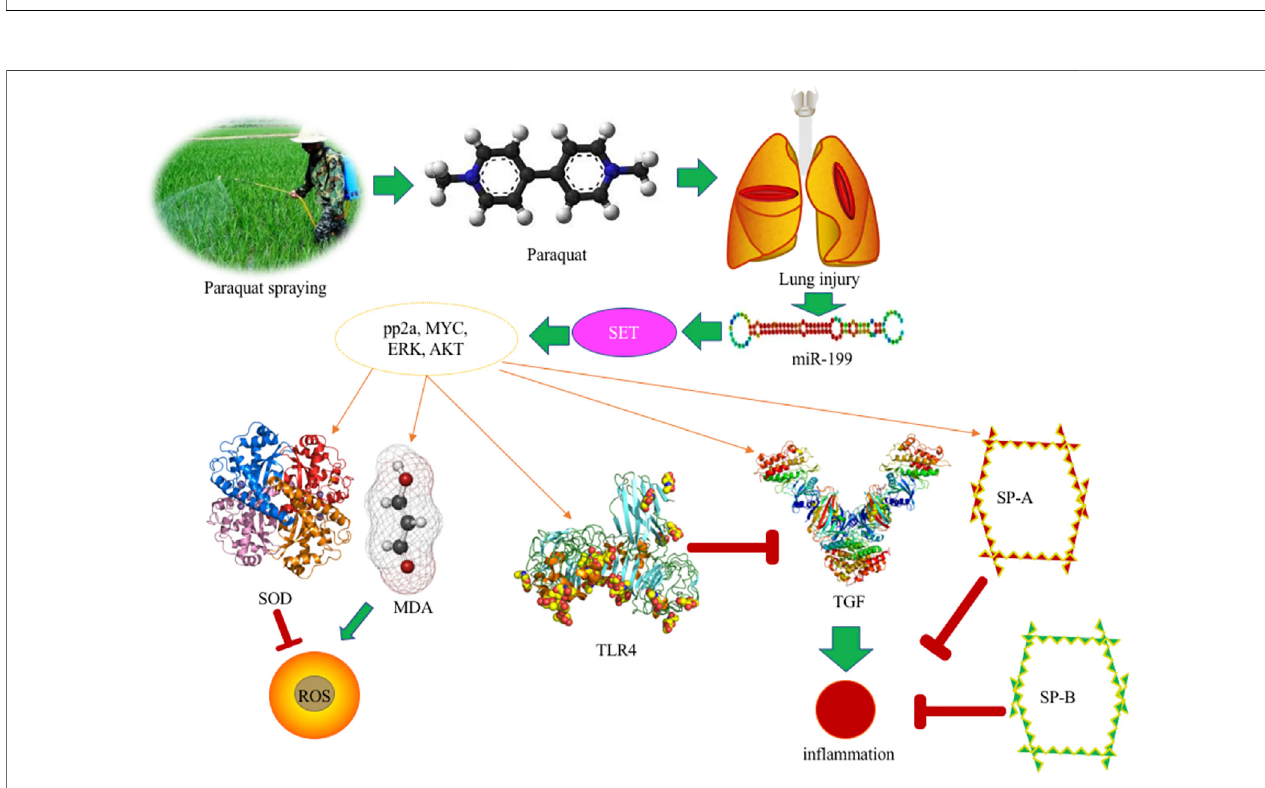
FIGURE 6 | Schematic plot of possible molecular mechanisms for PQ induced lung injury.